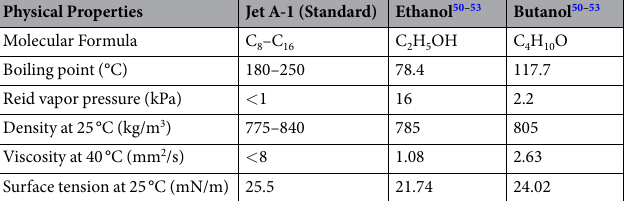
Table 2. Properties of the tested